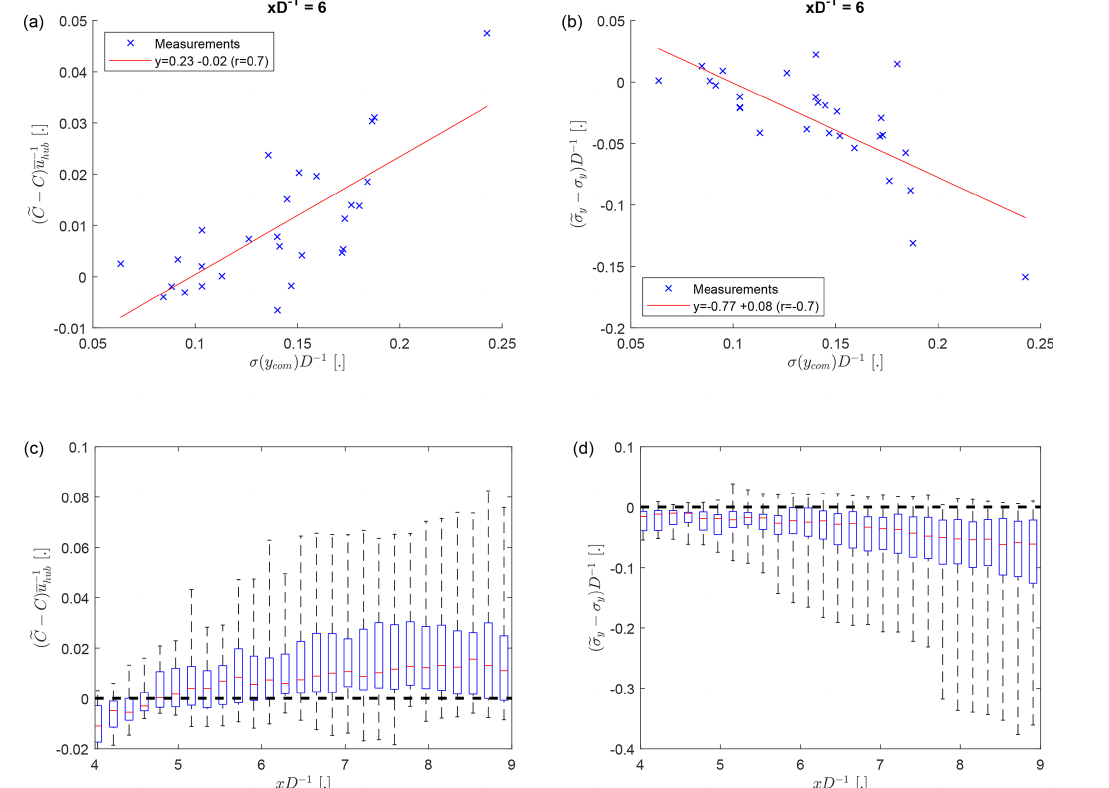
Figure 12. Difference of wake depth (a) and wake width (b) between the nacelle frame of reference and the meandering frame of reference as a function of the wake meandering strength. Wake depth and wake width of the nacelle frame of reference are C and σ y and of the meandering frame of reference are (cid:101) C and (cid:101) σ y . Panels (c) and (d) show the distribution of observed differences in depth and width as a function of xD − 1 . The whiskers show the range of the data, the top and bottom of the blue box indicate the 25th and 75th percentiles, and the red centre marker is the median.